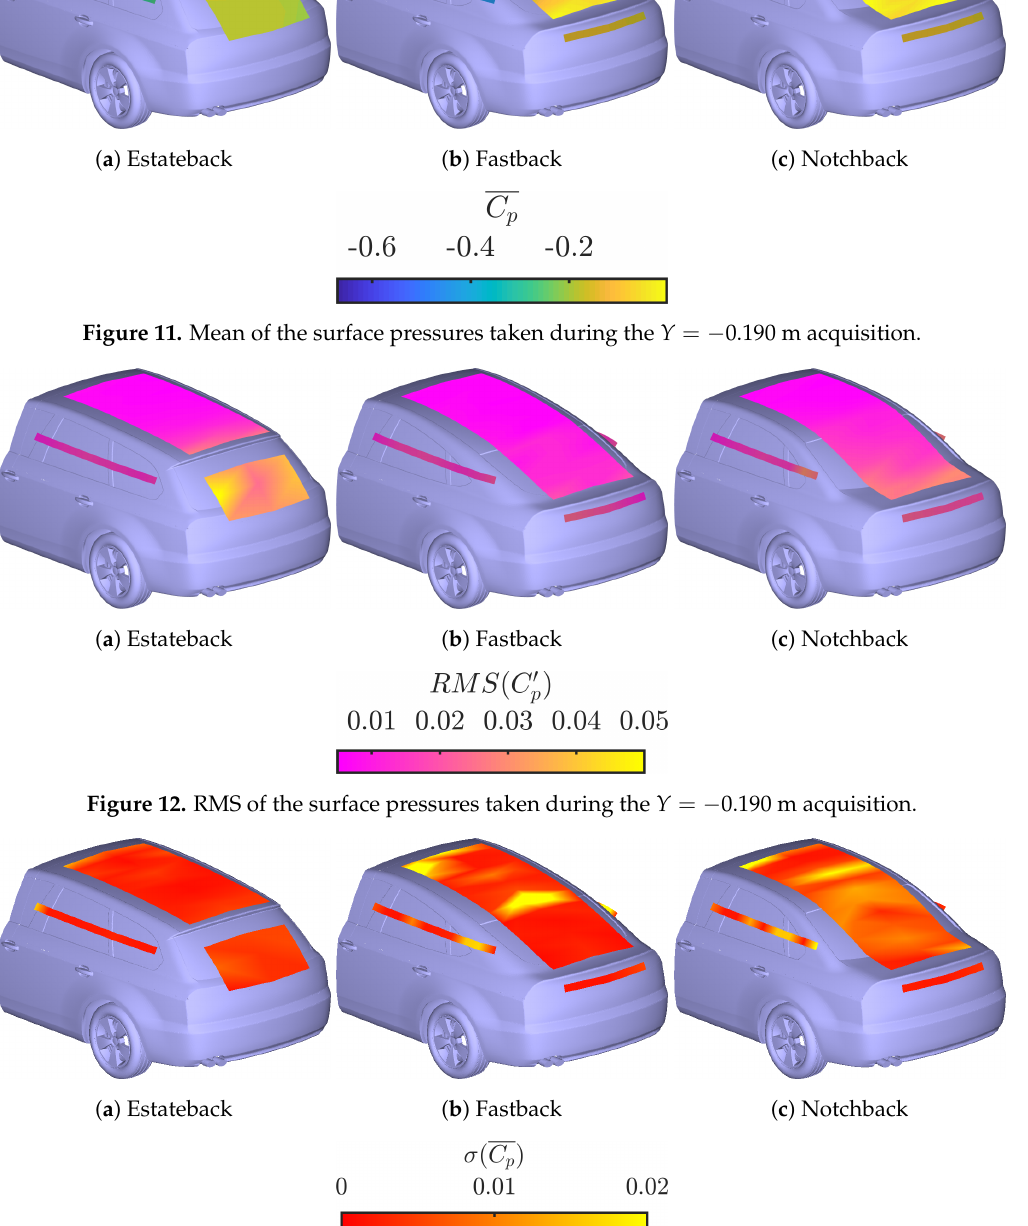
Figure 13. Standard deviation ( σ ) of the mean from all pressure tests, apart from Y = 0 m where the centreline pressure tapings were taped